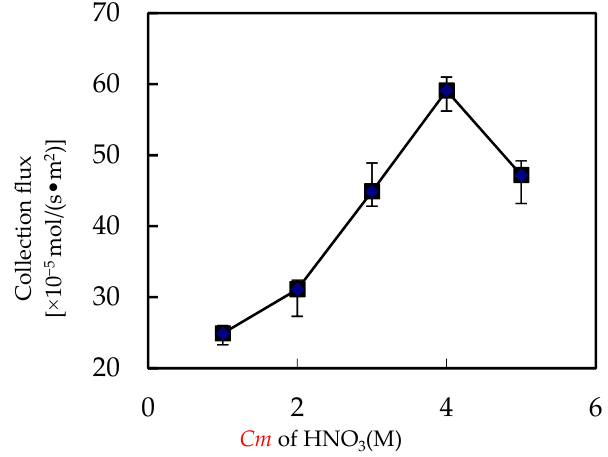
Figure 8. Influence of nitric acid Cm on collection of Ho(III) .